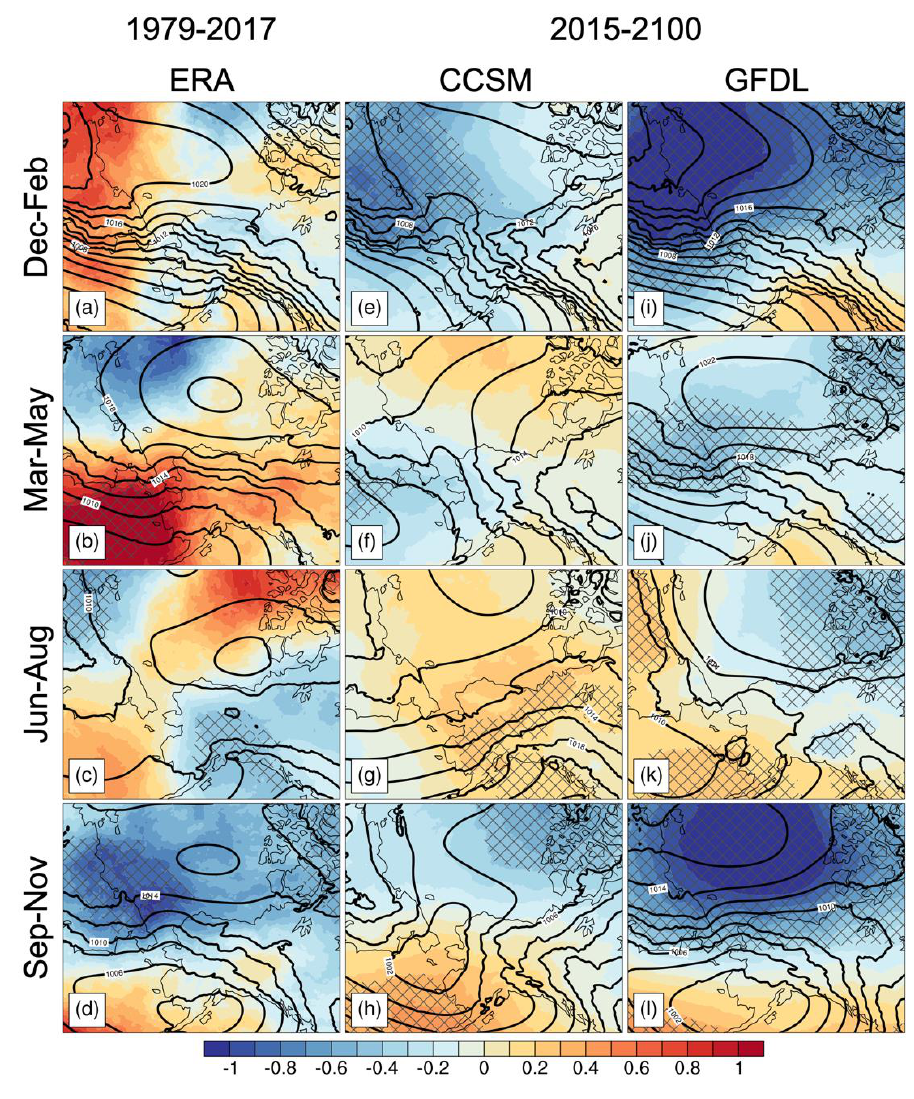
Figure 9. Seasonal sea level pressure trends and historical climatology for downscaled ( a – d ) ERA- Interim for, ( e – h ) CCSM, and ( i – l ) GFDL. Colors are sea level pressure trends (hPa/yr). Hatching denotes regions of trends significant at the 95% or greater level according to the Mann–Kendall test. Trends for ERA-Interim cover the 1979 – 2017 period while CCSM and GFDL are for the future 2015 – 2100 projection. Contours denote the historical climatologies (1979 – 2017) for the downscaled ERA- Interim reanalysis, CCSM and GFDL.